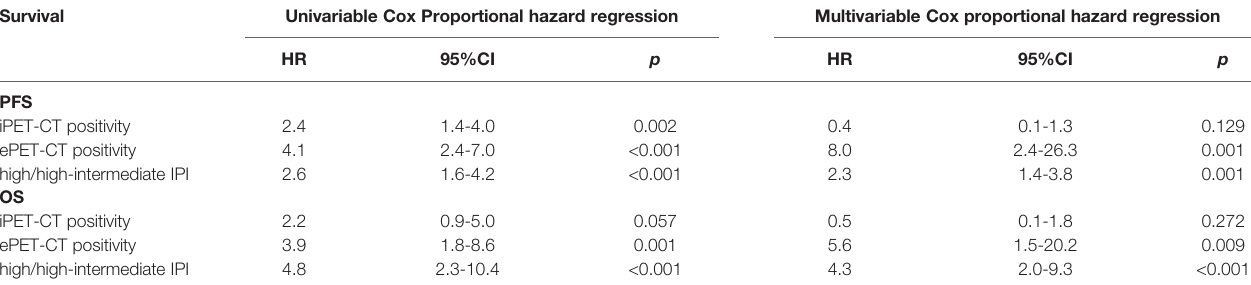
TABLE 2 | Univariable and multivariable analysis of PFS and OS. Survival Univariable Cox Proportional hazard regression Multivariable Cox proportional hazard